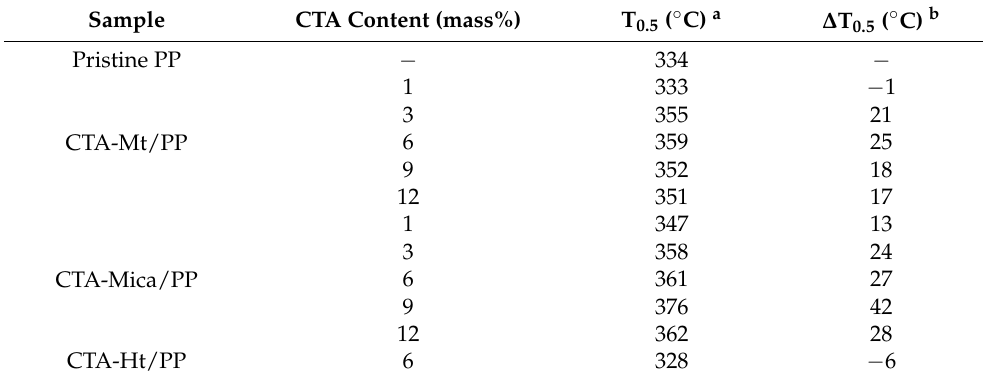
Table 2. Thermal stability of CTA-clay/PP nanocomposites compared to pristine PP.